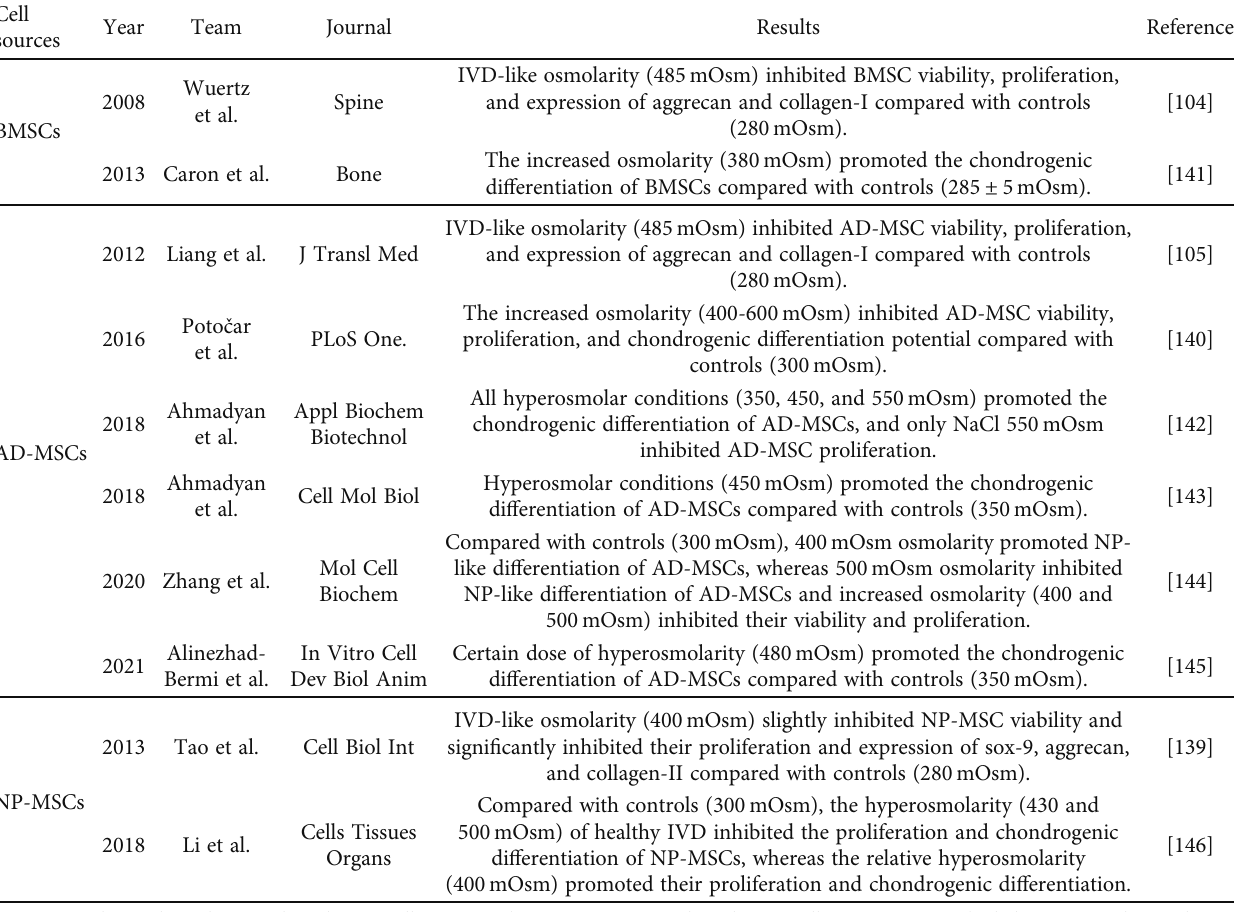
Table 5: E ff ects of osmotic cell pressure on the biological behavior of